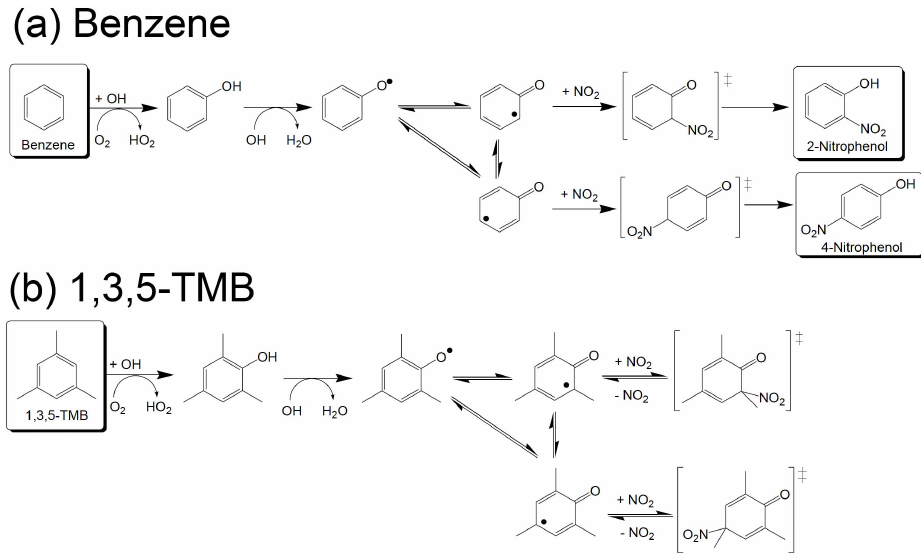
Fig. 6. Reaction schemes of (a) nitrophenol formation from the photooxidation of benzene and (b) corresponding routes from the photooxi- dation of